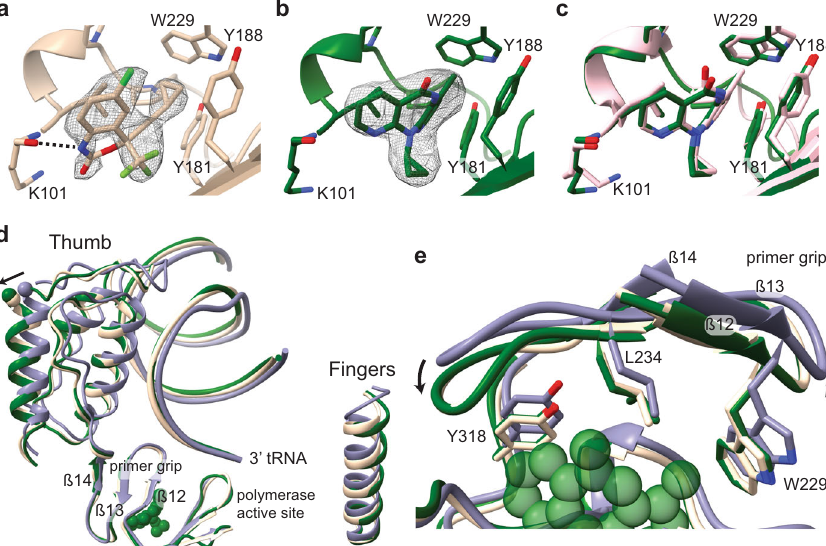
Fig. 4 NNRTI inhibition of the RTIC. a miniRTIC – EFZ NNRTI-binding pocket. EFZ N1 atom forms a hydrogen bond (black dashed line) with the oxygen atom on the backbone of K101. Corresponding EFZ density in mesh from 2.9-Å EM map. Y181 and Y188 fl ip toward the polymerase-active site to accommodate the drug. b miniRTIC – NVP NNRTI-binding pocket. Corresponding NVP density in mesh from 3.1-Å EM map. Similar to a , Y181 and Y188 fl ip to accommodate the drug. c Superposed binding pocket of miniRTIC – NVP (green) and RT – DNA – NVP (pink, 3V81 [https://doi.org/10.2210/pdb3v81/ pdb]) after alignment on palm domain backbone residues ( “ Methods ” ). d Superposed apo-miniRTIC (purple), miniRTIC – EFZ (beige), and miniRTIC – NVP (green) after alignment on palm domain backbone residues ( “ Methods ” ). NNRTI binding locks the primer grip, causing the thumb to hyperextend by ~2 Å. e NNRTI binding causes compaction of the primer grip by ~2 Å to assist in the hydrophobic packing of the drug. The primer grips of both miniRTIC – NVP (green) and miniRTIC – EFZ (beige) exhibit similar compaction motions in reference to apo-miniRTIC